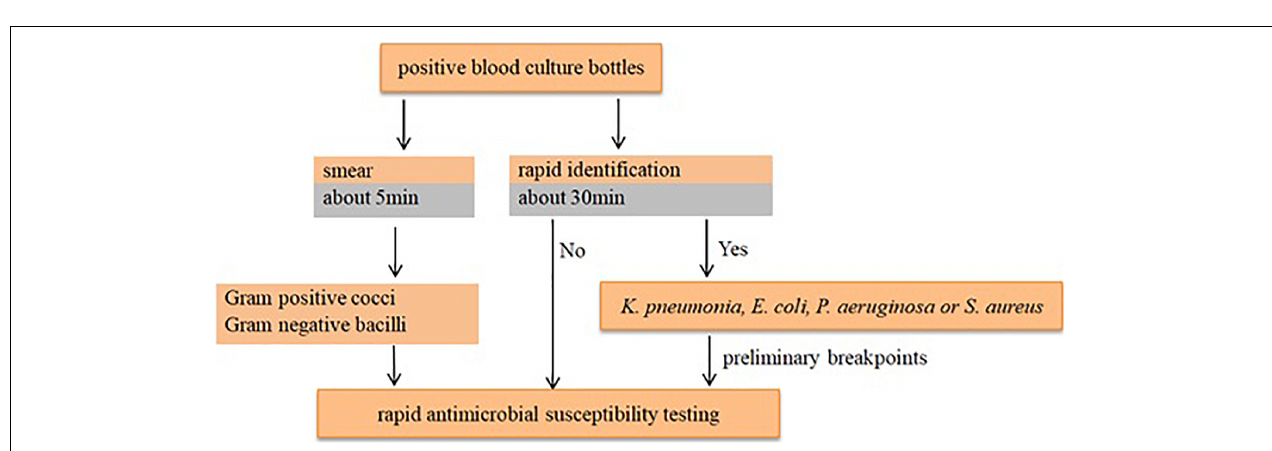
FIGURE 1 | The rapid antimicrobial susceptibility testing (rAST) of E. coli and K. pneumoniae with imipenem between sensitive strain and resistant strain and the preliminary breakpoint (PBP) distribution. (A) 4 h of incubation. (B) 6 h of incubation. (C) 8 h of incubation. (D) 18 h of incubation. R, resistant strains; S&I, sensitive and intermediate strains.